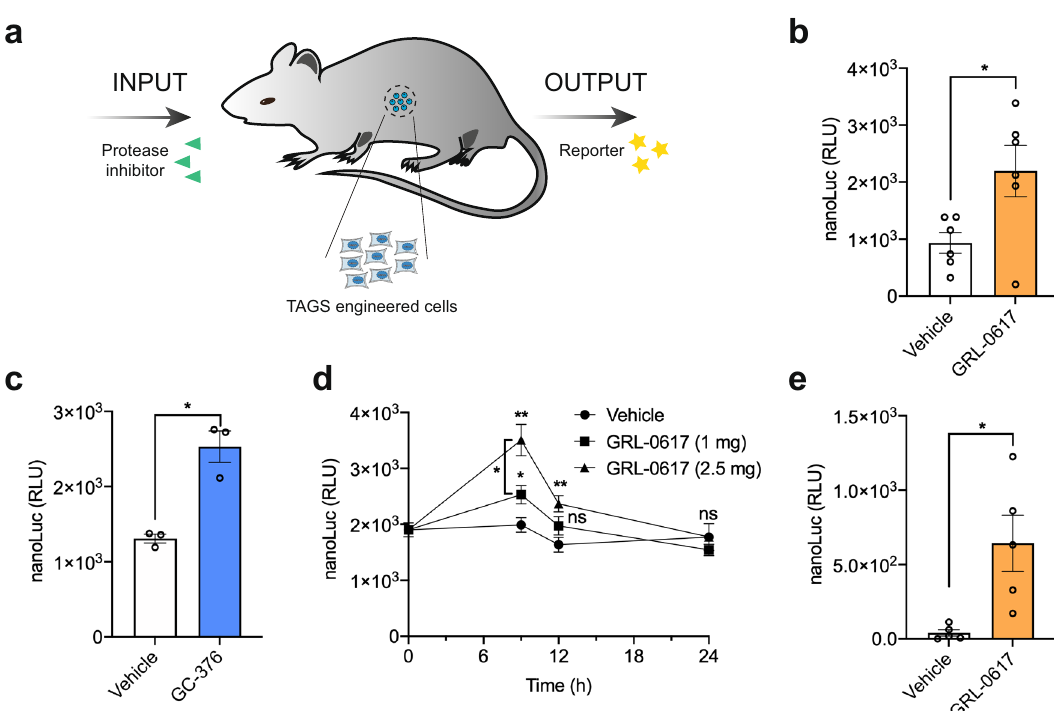
Fig. 6 TAGS functionality in vivo. a Schematic of TAGS function in vivo. Protease inhibitor activates encapsulated TAGS-engineered cells or in vivo- transfected cells, resulting in reporter nanoLuc expression. b PLpro-TAGS performance in vivo. PLpro-TAGS-engineered cells were intraperitoneally implanted into mice, which then received either GRL-0617 (2.5 mg) or vehicle via o.g.. NanoLuc in the blood was quanti fi ed at 6 h thereafter. c Mpro-TAGS performance in vivo. Mpro-TAGS-engineered cells were intraperitoneally implanted into mice, which then received either GC-376 (5 mg) or vehicle via o.g.. NanoLuc in the blood was quanti fi ed at 6 h thereafter. d PLpro-TAGS activation kinetics in vivo. PLpro-TAGS-engineered cells were intraperitoneally implanted into mice, which then received either 1 mg or 2.5 mg of GRL-0617 or vehicle via o.g.. NanoLuc in the blood was quanti fi ed at different time points thereafter. e Performance of PLpro-TAGS delivered via hydrodynamic injection. PLpro-TAGS-engineered mice received either GRL-0617 (2.5 mg) or vehicle via o.g.. NanoLuc in the blood was quanti fi ed at 6 h thereafter. Plot b shows the mean ± SEM, with individual data points, n = 6 mice. Plot c shows the mean ± SEM, with individual data points, n = 3 mice. Plot d shows the mean ± SEM, n = 6 mice. Plot e shows the mean ± SEM, with individual data points, n = 5 mice. Statistical signi fi cance was calculated by means of Welch ’ s two-tailed t -test, * P < 0.05, ** P < 0.01, ns, not signi fi cant; exact P values are provided in Supplementary Table 7. Source data for this fi gure is provided in a Source Data fi